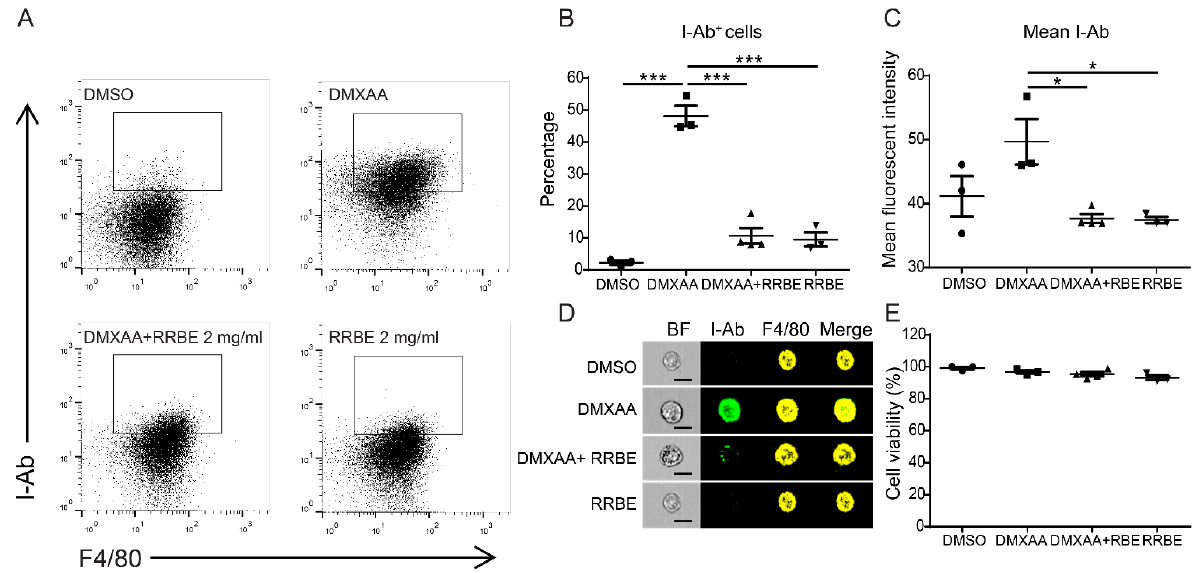
Figure 2. RRBE decreases the maturation of murine RAW 246.7 macrophage cells. RAW246.7 macrophages were co-stained with the macrophage surface marker (F4/80) and MHC-II molecules (I-Ab), and subsequently determined by a flow cytometer. ( A ) The representative of flow cytometry, ( B ) percentage and ( C ) mean fluorescent intensity of F4/80+ I-Ab+ cells after DMXAA stimulation with and without RRBE for 24 h (N = 3 – 4). ( D ) The morphology detected by imaging flow cytometry shows the representative of I-Ab (green) and F4/80 (yellow). Dead cells were excluded (N = 3) (scale bar, 20 µm). ( E ) MTS assay was used to determine cell viability (N = 3 – 4). Error bar shown as mean ± SEM (* p < 0.05 and *** p < 0.001).